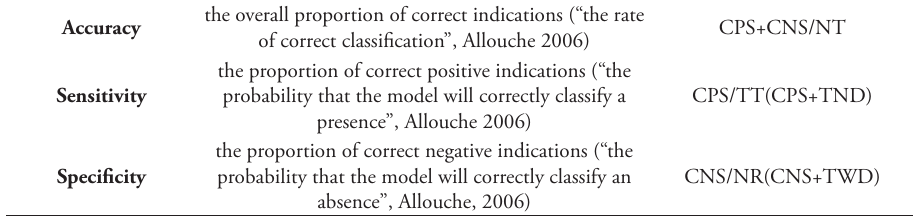
Table 3. Definition and formulae to calculate Accuracy, Sensitivity and Specificity. CPS: correct posi- tive signalling (total n° of targets present in trees and correctly detected and signalled by the dog); CNS: correct negative signalling (total n° of trees without target and not signalled); NT: total n° of trees inves- tigated; TT: total n° of targets present in the trees; TND: target not detected (total n° of targets present in the trees and not detected); NR: no reaction; TWD: targets wrongly detected (total n° of trees without target signalled by the dog as if the target was